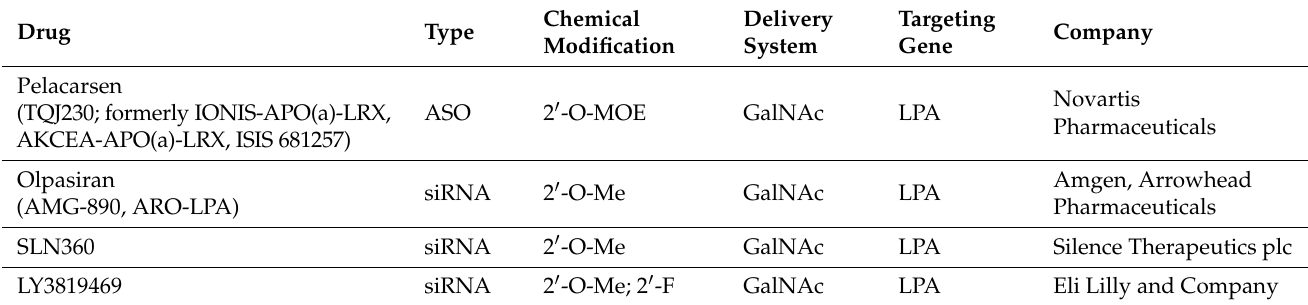
Table 4. RNA-based Lp(a)-lowering therapeutics under clinical